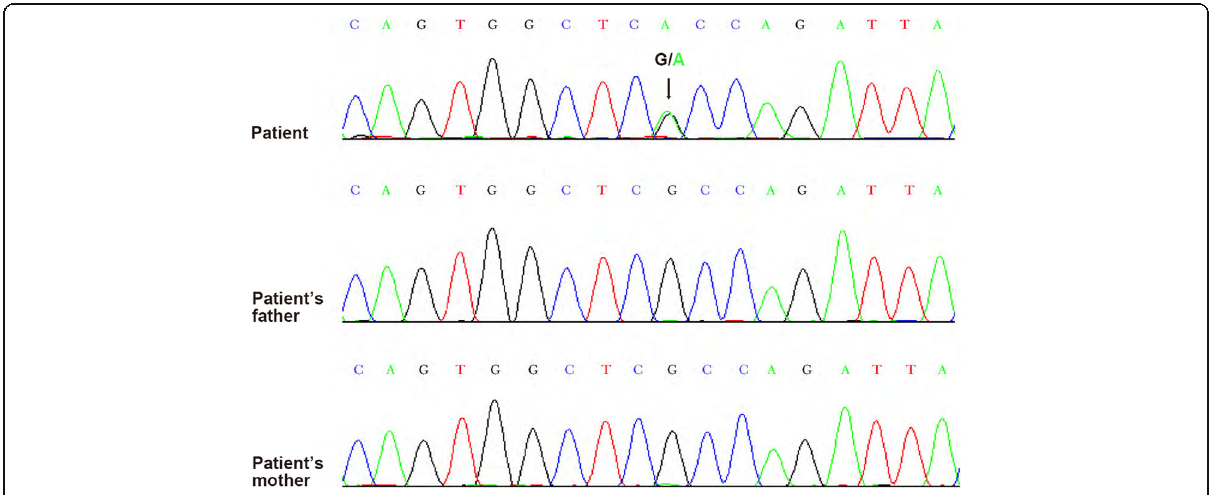
Fig. 6 The patient ’ s DNA sequencing of the ACVR1/ALK2 demonstrating a heterozygous mutation (c.617G > A; p.R206H) (arrows). The DNA sequencing of the patient ’ s parents without the